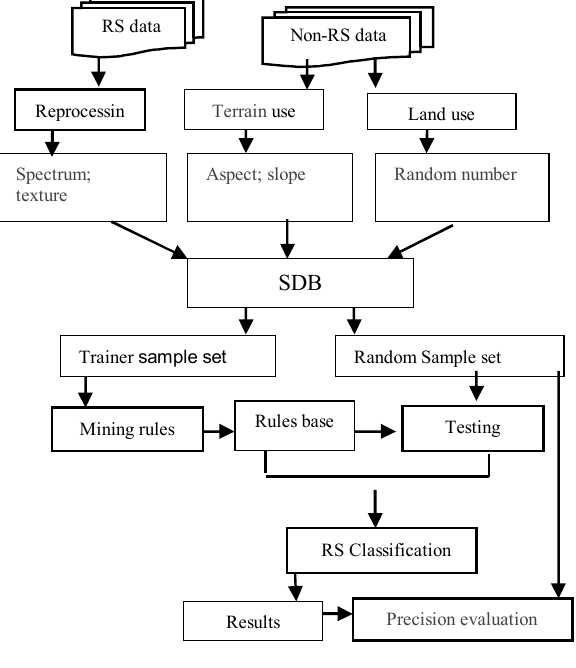
Figure2. Work flow